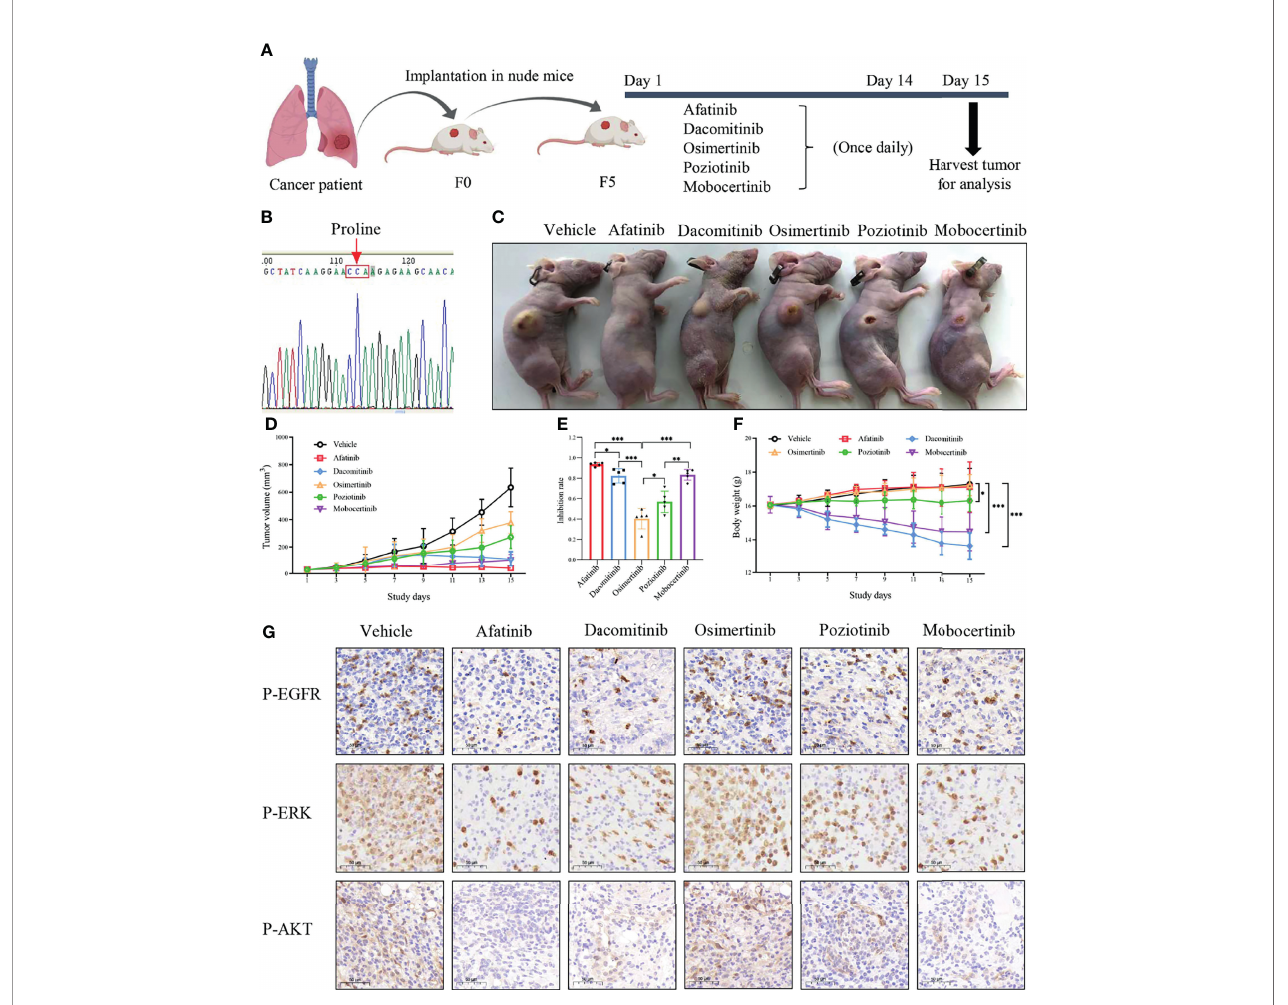
FIGURE 5 | Oral gavage of vehicle, afatinib, dacomitinib, osimertinib, poziotinib, mobocertinib according to the dosing schedule (A) in a p.L747P-mutant patient- derived xenograft model (B) . EGFR TKIs for the antitumor tumor activity (C) , tumor volume (D) , tumor inhibition rate (E) and mice body weight (F) in p.L747P-mutant xenograft mouse model. Phosphorylated EGFR, and its downstream molecules phosphorylated ERK and phosphorylated AKT under inhibition of different EGFR TKIs by IHC analysis (G) . *P < 0.05; **P < 0.01; ***P <